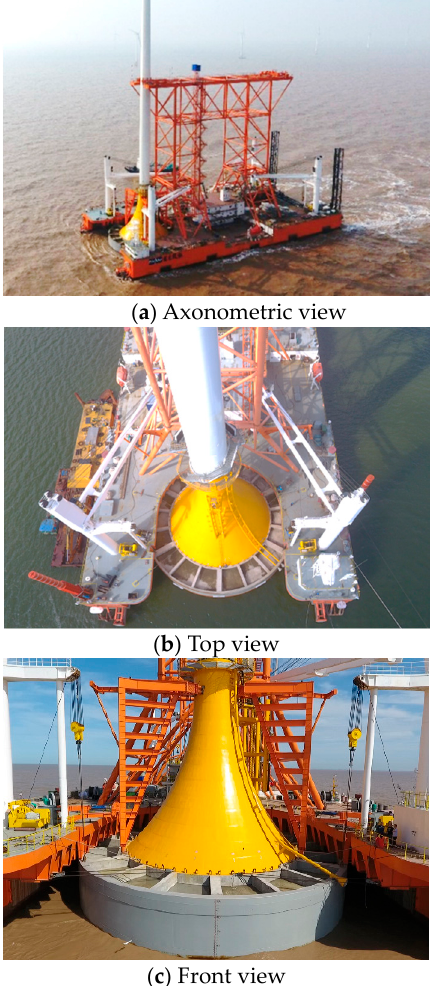
Figure 4. The prototype used for one-step transport. Table 1. The parameters of the overall structure.